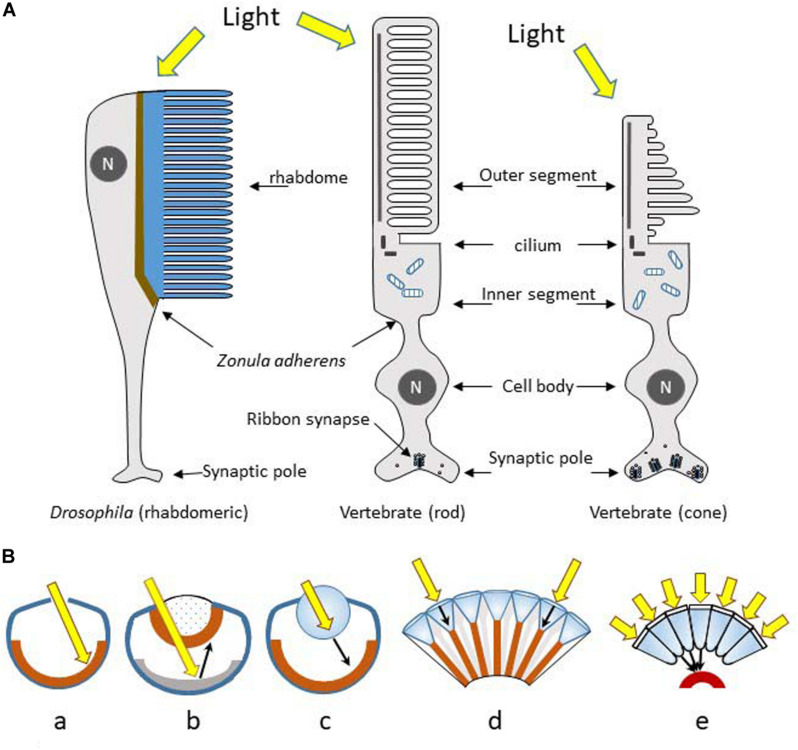
(A) Rhabdomeric microvilli-based (invertebrates) and cilia-based (vertebrates) photoreceptors display conserved cell polarity and topology. They evolved most probably from a common ancestor in early Bilateria. The photosensory pole is made of stacks of plasma membrane separated from the baso-lateral membrane by a zonula adherens. N, nucleus. (B) The main optical designs of eyes: (a) The pinhole eye; light (yellow arrow) falls directly upon the photoreceptors (brown layer). (b) The concave-mirror eye; light crosses the retina, and is then focused back onto the retina upon reflection from a hemispheric reflective mirror (tapetum, grey zone). (c) The camera type eye; light is focused by the lens to form an image on the retina. (d and e) The compound eyes; light reaches the photoreceptors exclusively from the small corneal lens (d type) located directly above, or focused through a large number of corneal facets and cones to be directed towards single rhabdoms (e type). Redrawn from Warrant (2019).